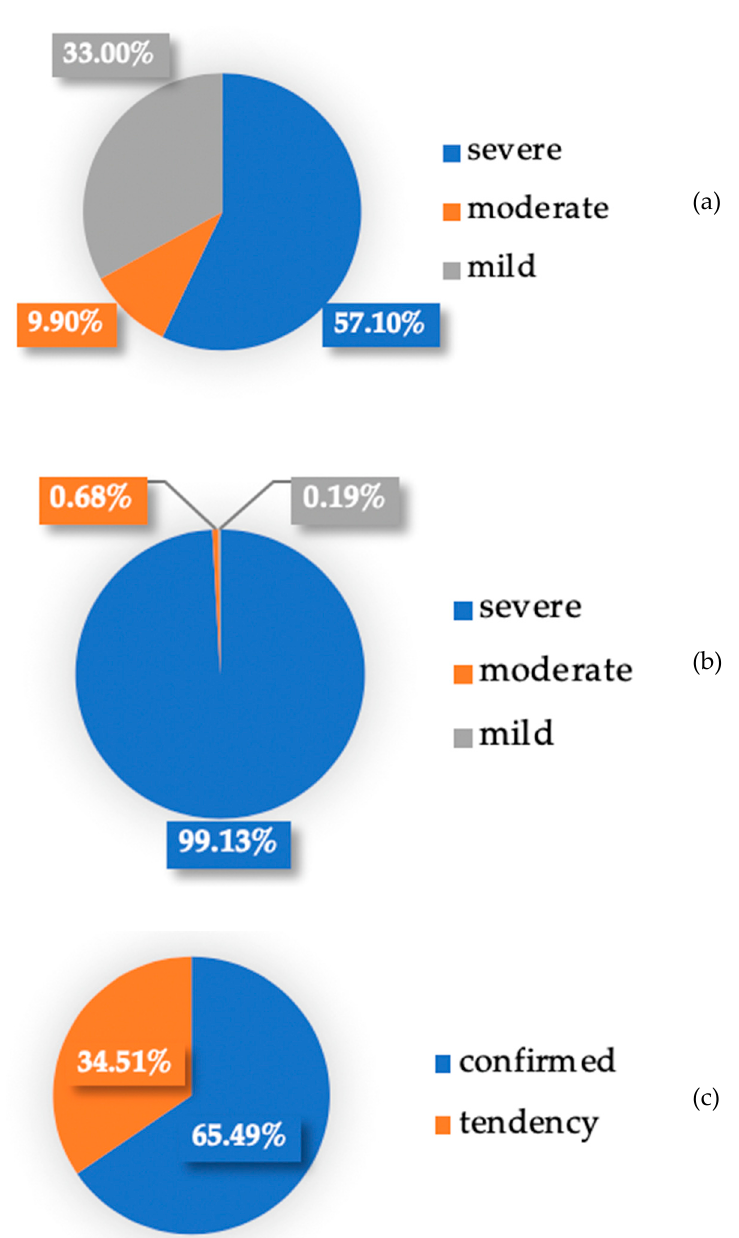
Figure 6. The proportion of identified users with different status. ( a ) Proportion of the confirmed statue in mental disorders; ( b ) proportion of the tendency statue in mental disorders; ( c ) proportion of the confirmed and tendency among mental disorders.